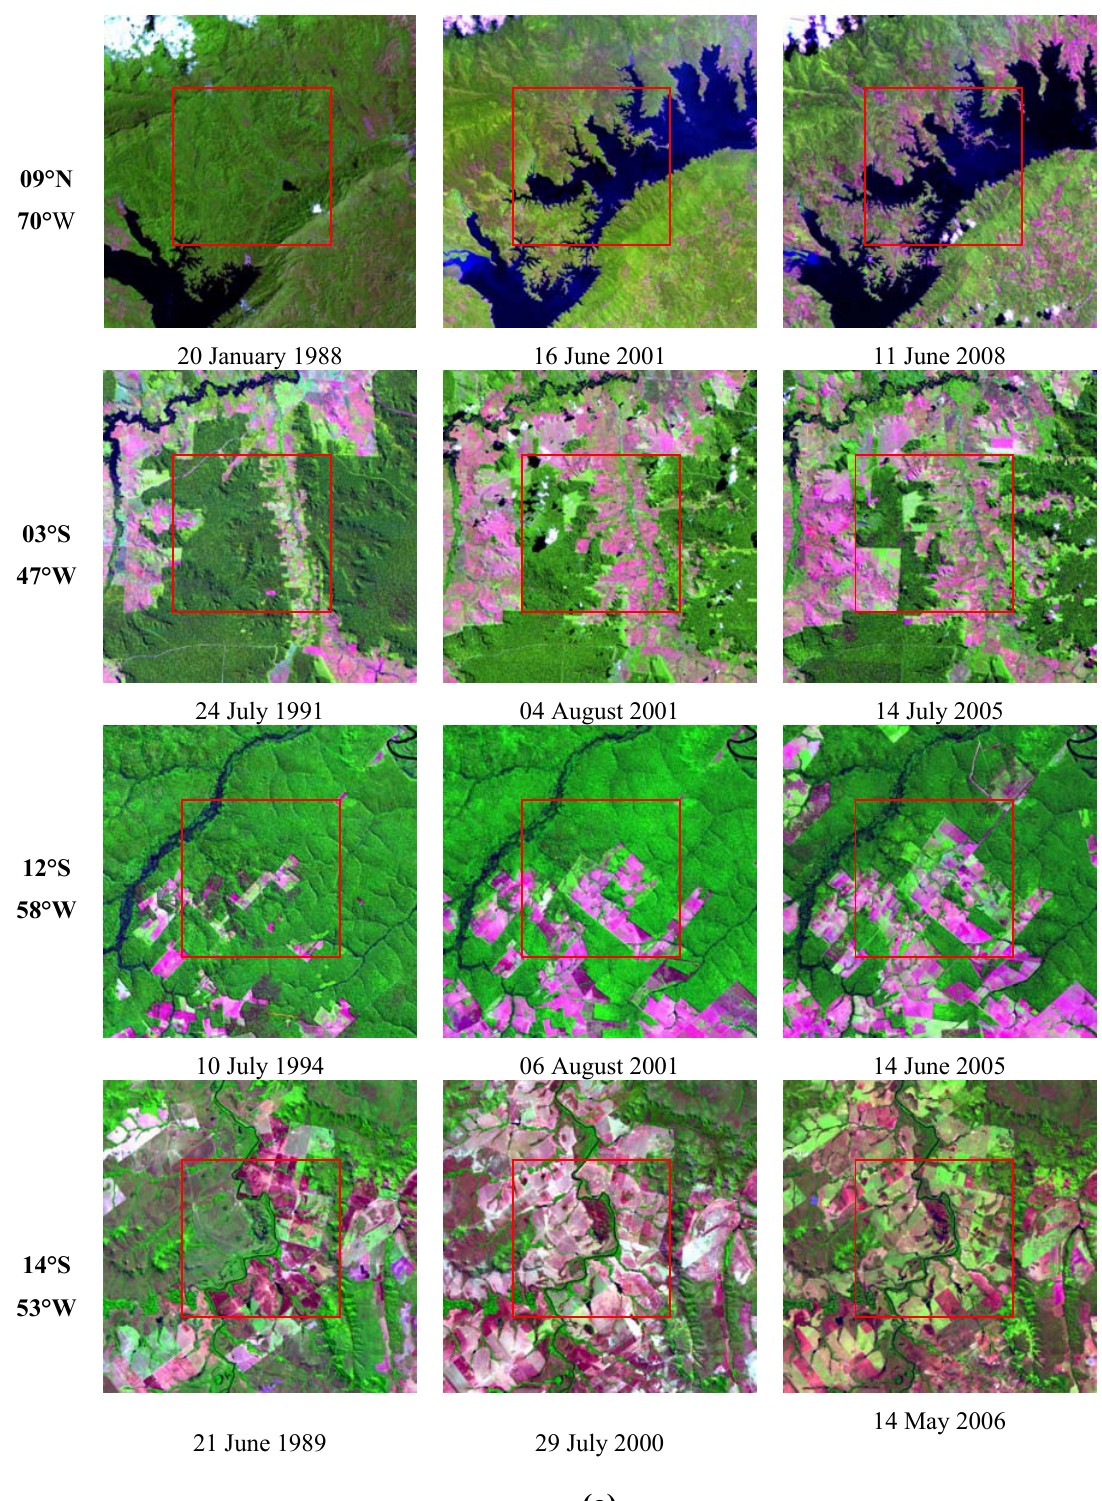
Figure 2. ( a ) Landsat satellite imagery (20 km × 20 km box size) at 30 m resolution with the 10 km × 10 km box highlighted in red; ( b ) Classification results obtained for the four example sample sites (10 km × 10 km